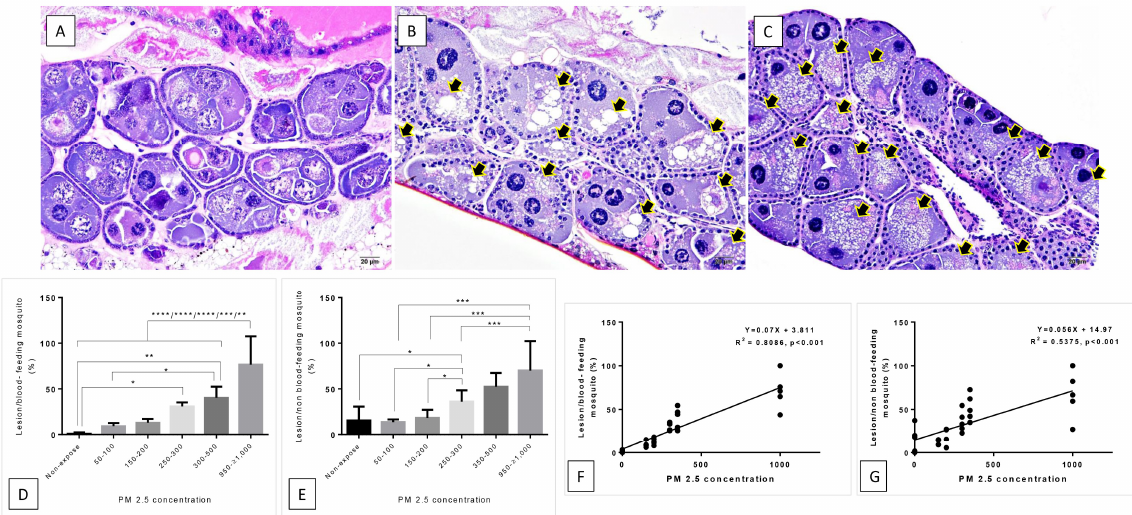
Figure 6. Ovarian histopathological change and its score from the female Ae. aegypti with or without PM 2.5 exposure in accordance with the correlation between the pathological severity and the concentration of PM 2.5 : comparing with negative control group as demonstrated by intact ovarian cells ( A ), the results show an increase in vacuolated degeneration (arrow) of the ovaries in both female Ae. aegypti with ( B ) and without ( C ) blood-feeding at the highest concentration (>1000 µ g/m 3 ). The pathological severity tends to increase as concentrations of PM 2.5 increase in the mosquitoes both with and without blood-feeding ( D – G ) (*: p < 0.05, **: p < 0.01, ***: p < 0.001, and ****: p < 0.0001), with a positive correlation at R 2 = 0.8086, p < 0.001, and R 2 = 0.5375, p < 0.001,